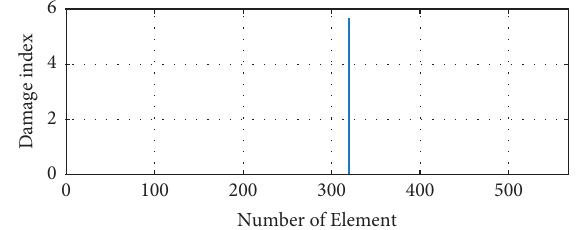
Figure 31: Results of single-damage case D2 using MCA-DI (building with the unsymmetrical distribution of columns).